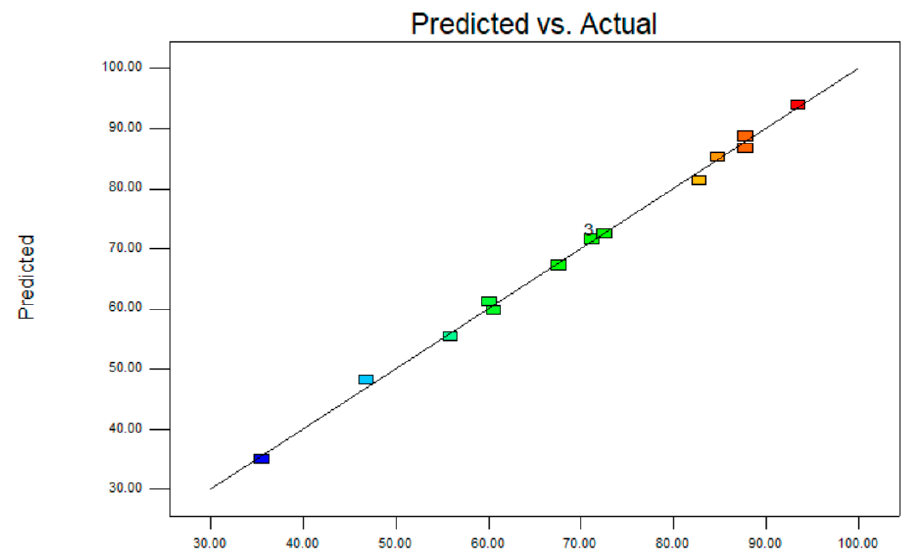
Figure 4. The relationship between the predicted and actual conversion of octyl cinnamate.